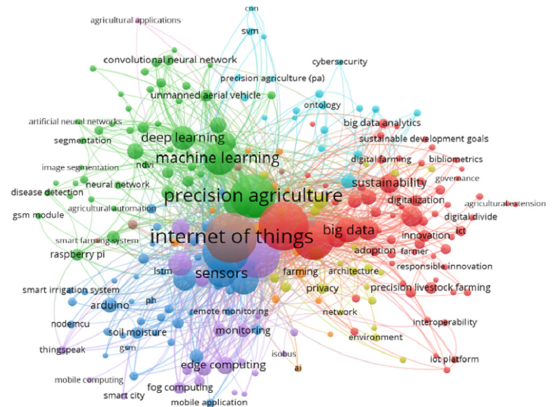
Figure 7. Network visualization–co-occurrence of author keywords. Source: Scopus-VOSviewer.